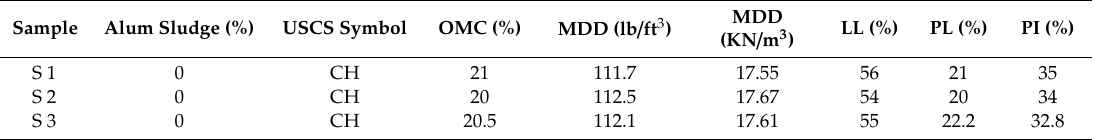
Table 2. Physical properties of soil